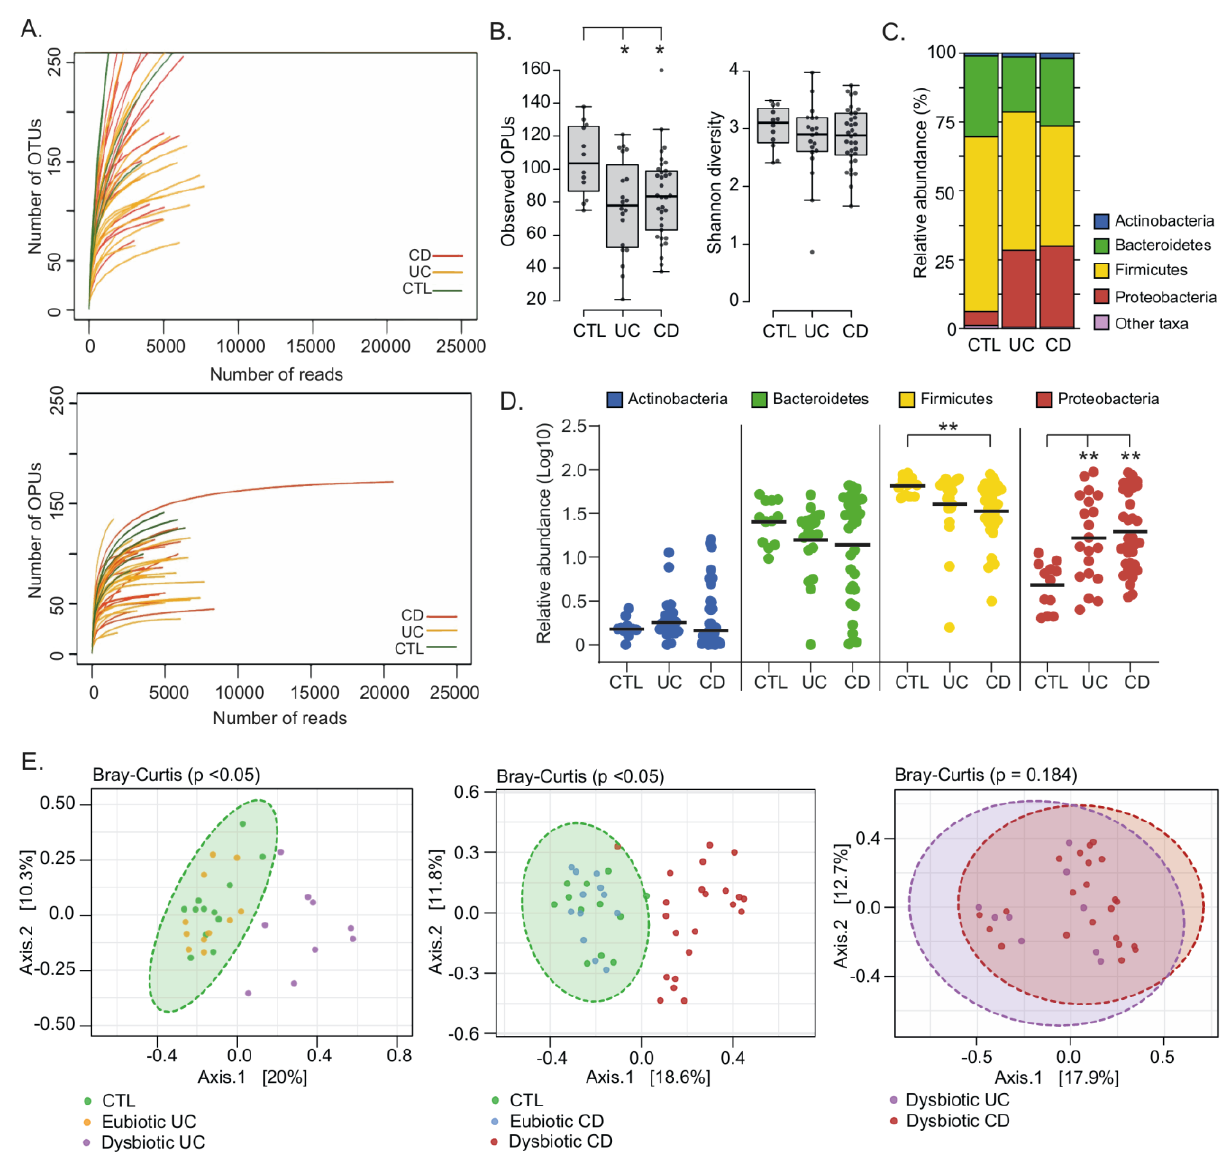
FIGURE 1: Landscape of mucosa-associated intestinal microbiota of Chilean and Spanish patients with IBD. (A) Rarefaction curves based on OTUs and OPUs detected in colonic biopsies from patients with ulcerative colitis (UC; orange lines) and Crohn’s Disease (CD; red lines), and control individuals (CTL; green lines). (B) Alpha diversity between patients and control individuals determined by the observed OPUs (Richness) and the Shannon index (Diversity). Significance: * p < 0.05, Kruskal- Wallis & Dunn’s tests. (C) Relative abundances (%) of the most prevalent phyla. Phyla with abundances < 1% are represented as other taxa. (D) Comparison of the relative abundances (Log10) of the four most common phyla. Each data point corresponds to a sample and horizontal lines to the means. Significance: ** p < 0.005, Kruskal-Wallis & Dunn’s tests. (E) A set of principal coordinate analysis (PCoA) plots based on Bray-Curtis distances showing the overall composition (beta diversity) of the microbiota in patients and controls. For a better visualization, individual PCoA plots are shown for the analysis of UC pa- tients versus controls (left panel), CD patients versus controls (middle panel) and dysbiotic UC versus dysbiotic CD patients. Each data point corresponds to a sample, which is colored according to the disease phenotype and the microbiota status (dysbiotic or eubiotic). Ellipses represent a 95% CI around the cluster